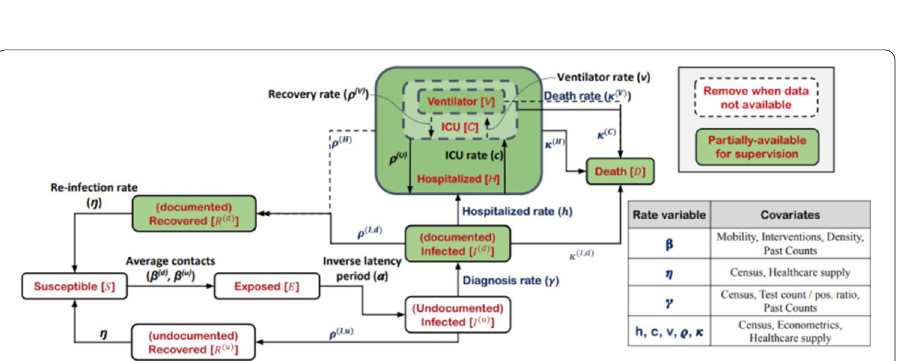
Fig. 20 Further differentiation within populations in the SIR model (Image taken from Arik et al.